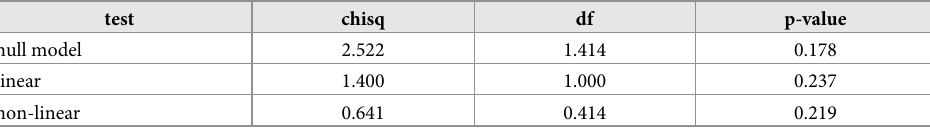
Table 3. Influence of systemic vascular